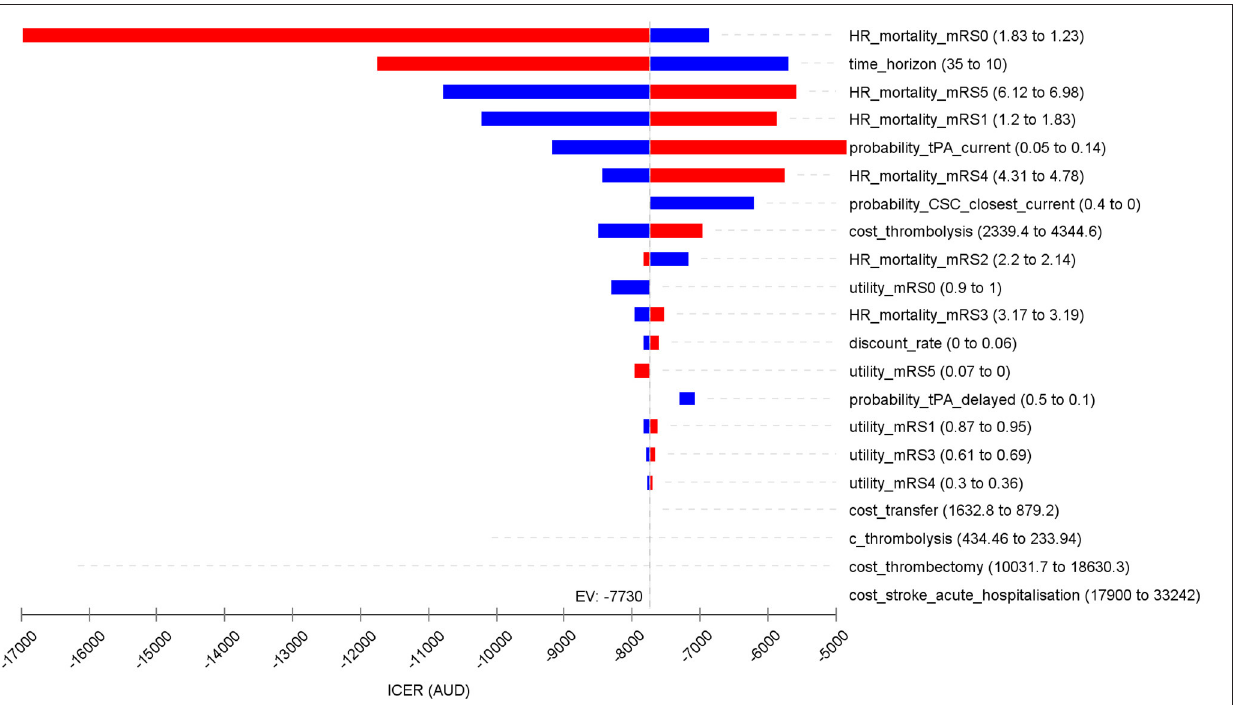
Frontiers in Neurology |